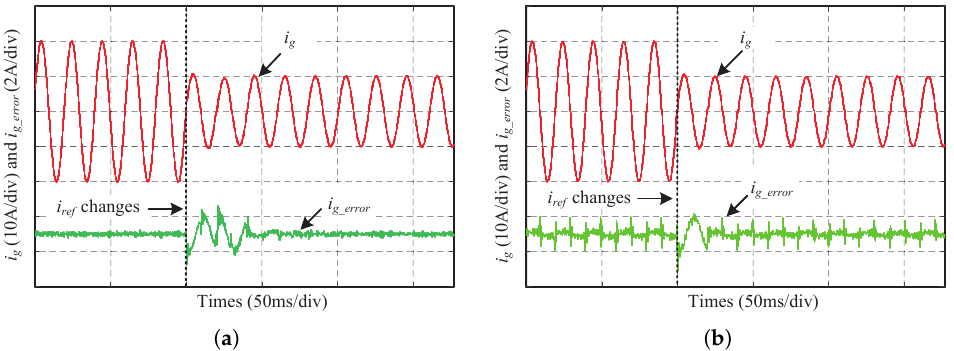
Figure 20. Transient waveforms and current errors of different control systems when reference current changes, with grid frequency f g = 49.6 Hz. ( a ) FA-IRC system. ( b ) PIMR-RC system.